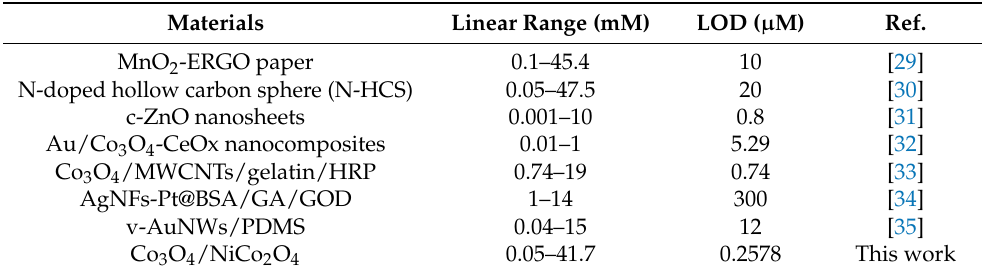
Table 1. Comparison of the performance of several different H 2 O 2 electrochemical